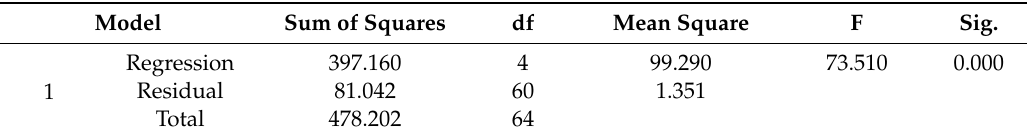
Table 4. ANOVA results.